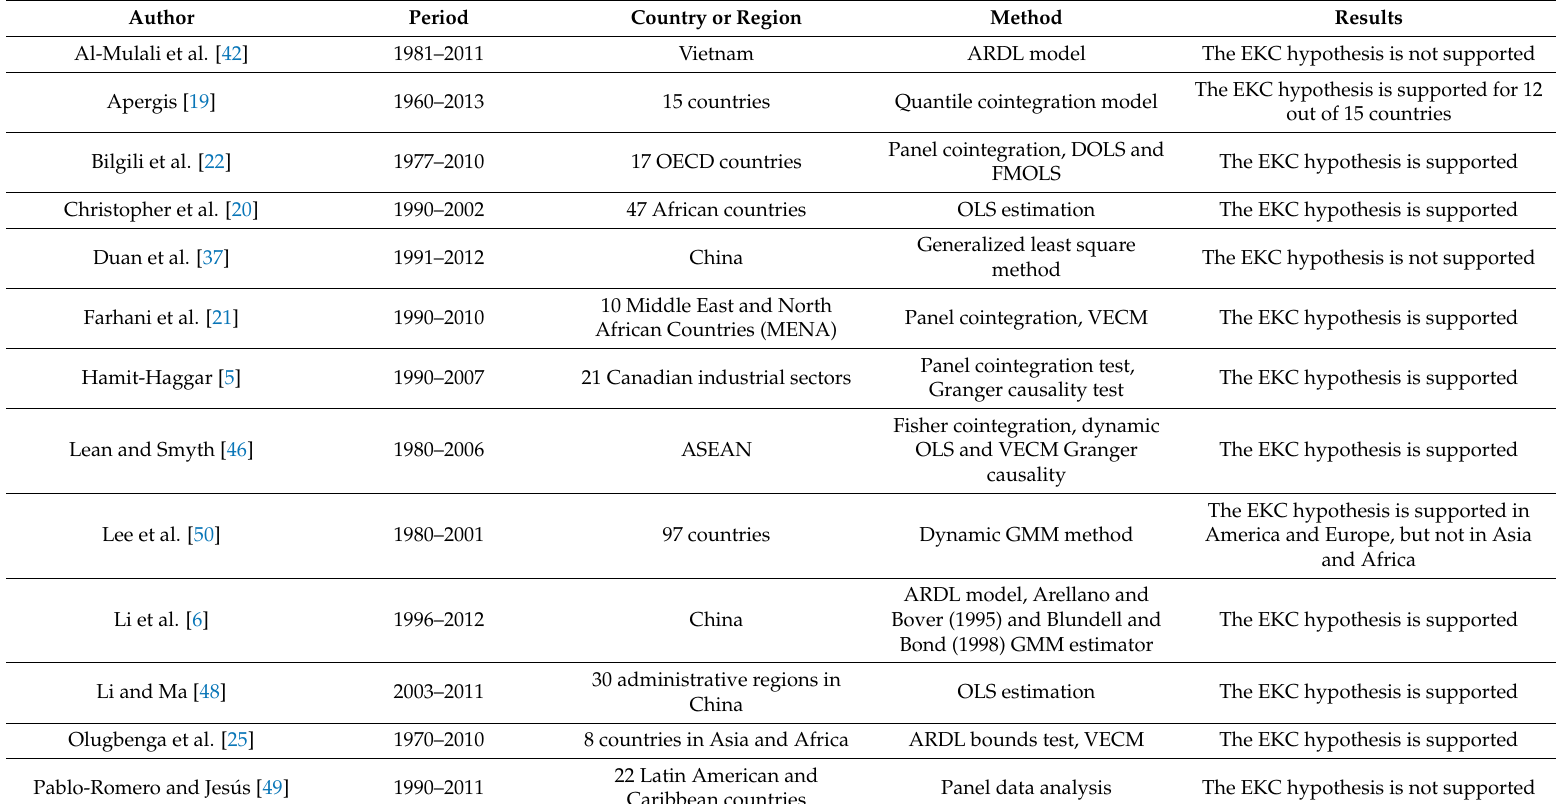
Table 1. Literature on the relationship of the energy-Environment Kuznets Curve